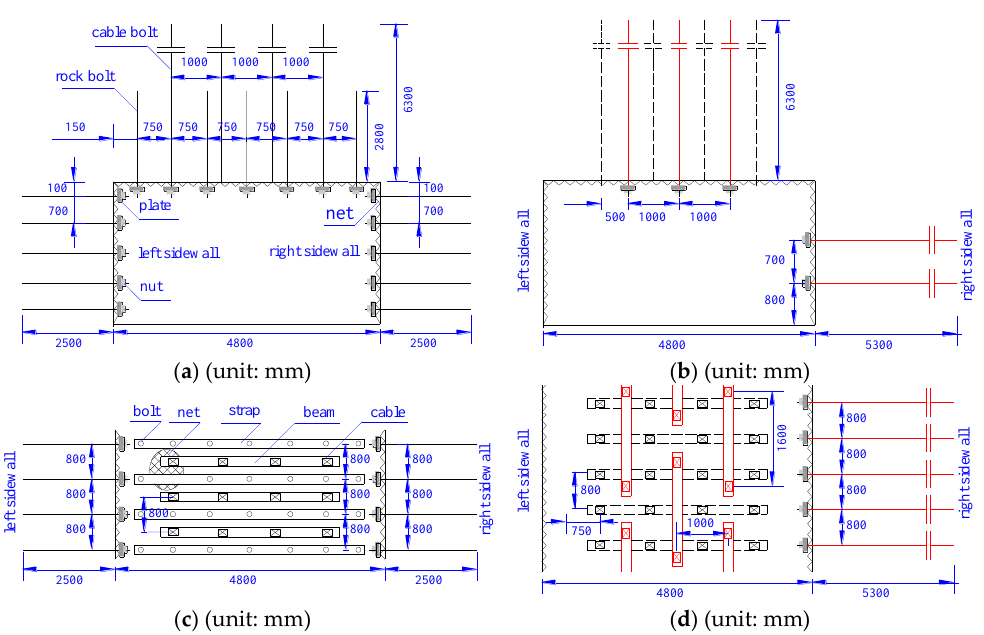
Figure 4. Supporting parameters in the first supporting stage: section view ( a ) and top view ( c ); and supporting parameters in the second supporting stage: section view ( b ) and top view ( d ).